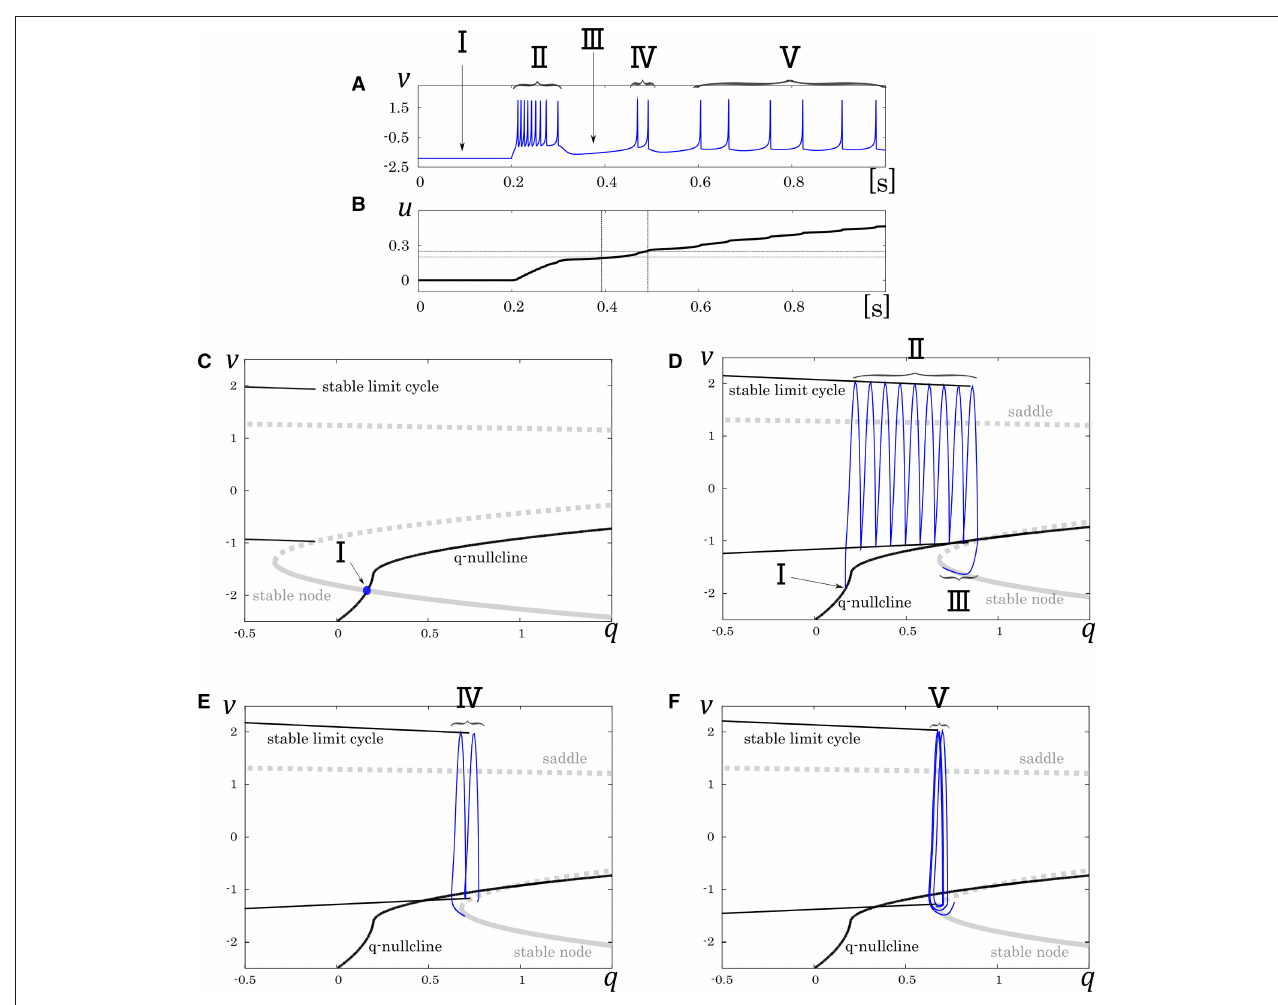
FIGURE 6 | Mathematical structure of the DSSN model in the IB class. (A) Waveform of the membrane potential in response to a step input that rises at t = 0.2 s. (B) Transition of the complementary variable u. (C) Projected mathematical structure without any input stimulus. Projected mathematical structure under a sustained stimulus where (D) u < r u 0 , (E) r u 0 < u < r u 1 , and (F) r u 1 < u . Each roman number corresponds to a spiking phase.